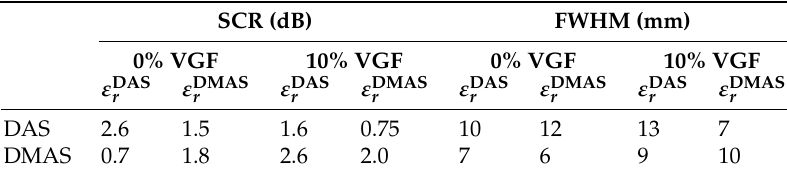
Table 1. The SCR and FWHM of images of breast phantoms without abnormalities containing 0% and 10% VGF, reconstructed with DAS and DMAS and a parameter search algorithm. For 0% VGF: ε DAS r = 10.5 and ε DMAS r = 9 whereas for 10% VGF, ε DAS r = 8.75 and ε DMAS r = 8. SCR (dB) FWHM (mm) 0% VGF 10% VGF 0% VGF 10% VGF ε DAS r ε DMAS r ε DAS r ε DMAS r ε DAS r ε DMAS r ε DAS r ε DMAS r DAS 2.6 1.5 1.6 0.75 10 12 13 7 DMAS 0.7 1.8 2.6 2.0 7 6 9